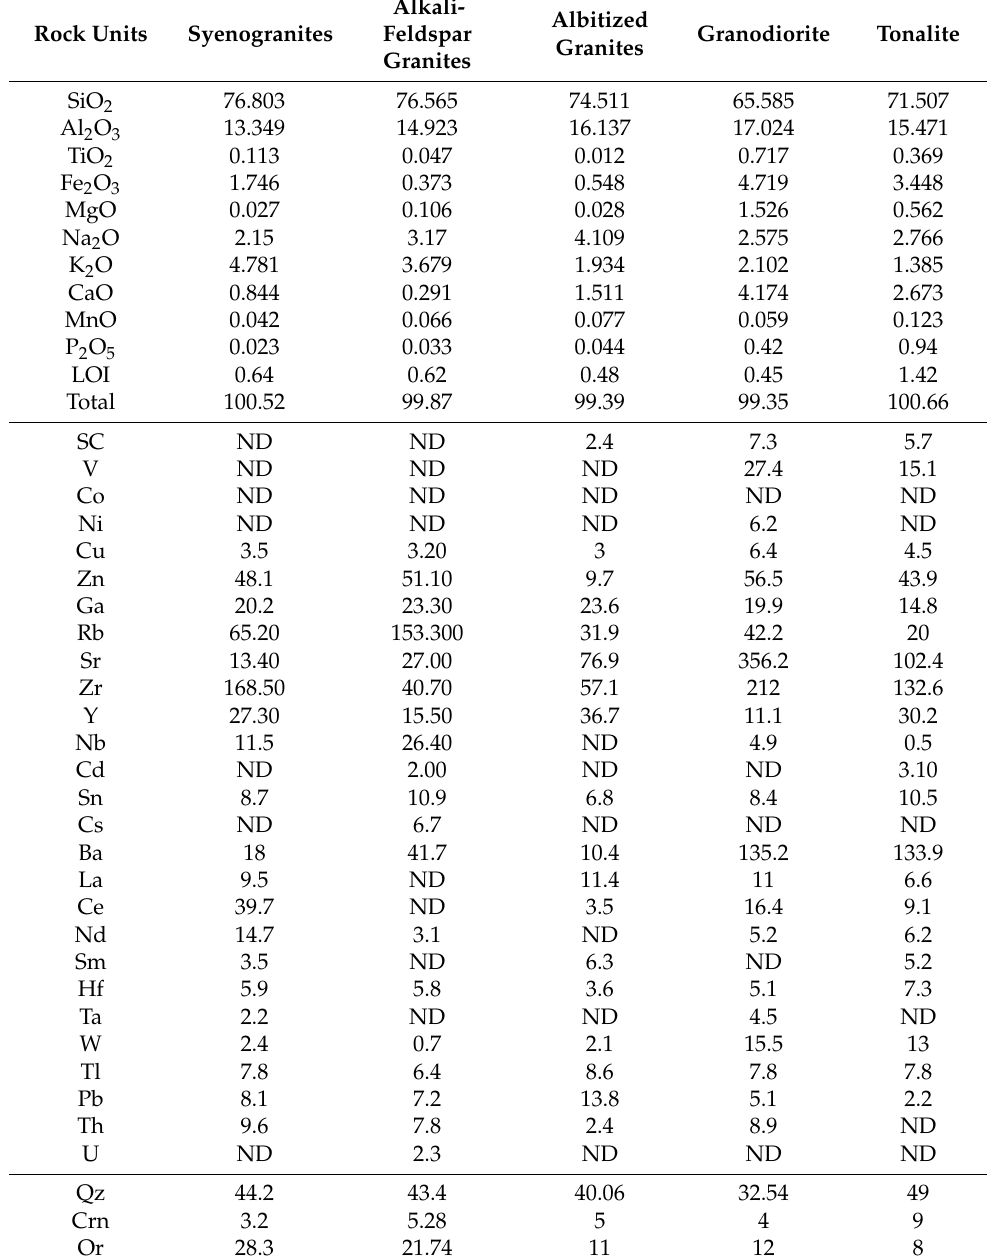
Table 1. Whole-rock analyses (major (%) and trace elements (ppm)) of the examined rocks and their normative